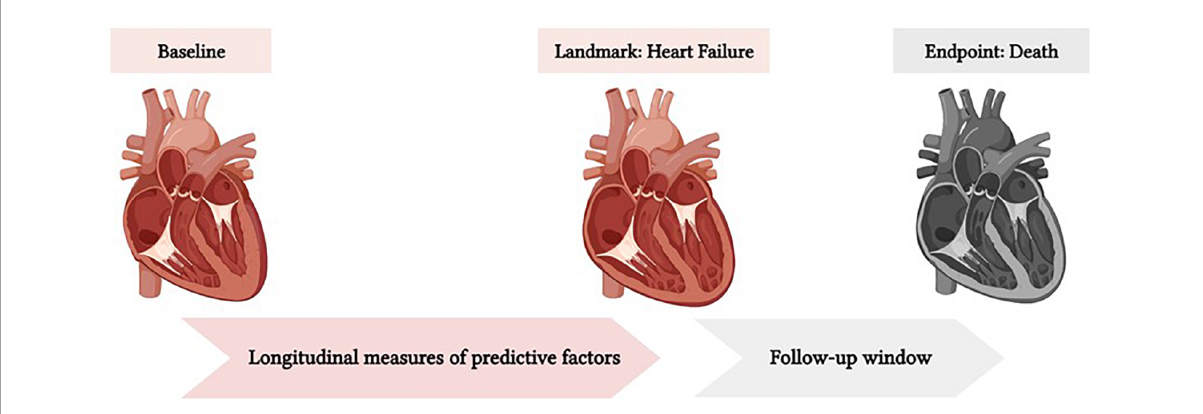
FIGURE1 The landmark of the survival analysis for this study was set at the time of HF diagnosis. The baseline for cumulative analysis was MESA exam 1 (Time Zero). The prediction window was from landmark to death or maximum follow-up time. The cumulative exposure to predictive factors from baseline to the landmark was used to predict mortality after heart